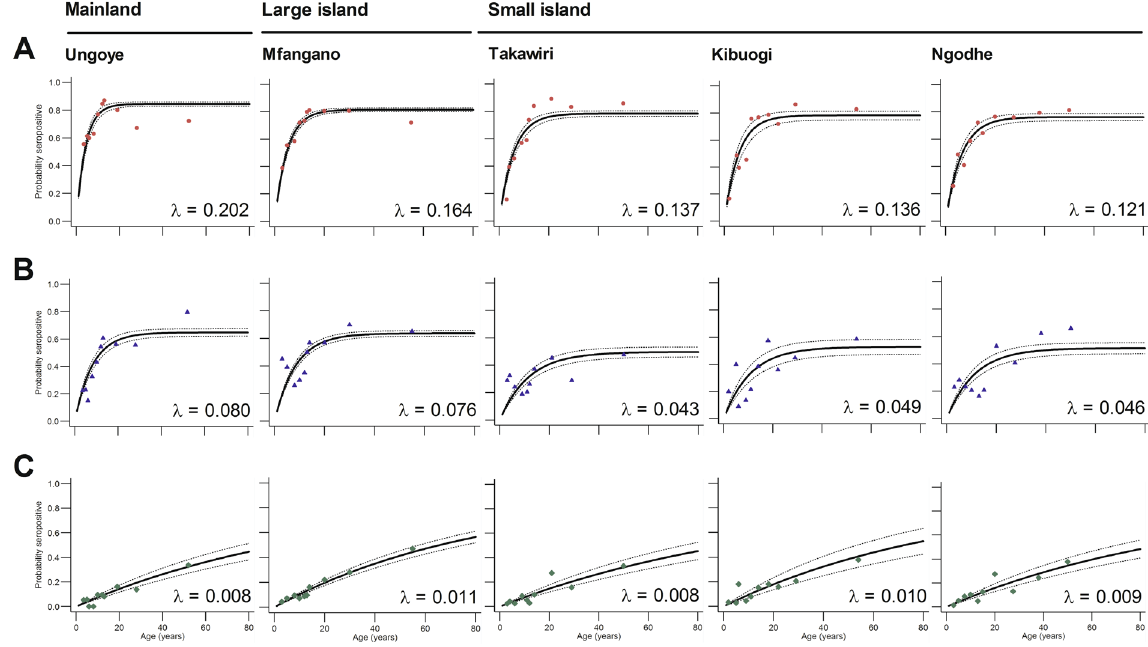
Figure 3. Annual probability of seroconversion rate for specific malaria antigen by age in each setting. Maximum-likelihood fits from reversible catalytic equilibrium model from each setting are shown. λ , the area- specific annual rate of seroconversion. ( A ) AMA-1, ( B ) MSP-1 19 , ( C ) CSP. The model was constrained to fit a single value for the annual probability of a common seroreversion rate ( ρ ), which was estimated; AMA-1: 0.0377 (95% CI 0.0312–0.0456); MSP-1 19 : 0.0433 (95% CI 0.0330–0.0568); CSP: 0.0011 (95% CI 0.0000–0.61138). Points indicated observed seroprevalence and solid lines show model-predicted seroprevalence. Broken lines are 95% confidence intervals.